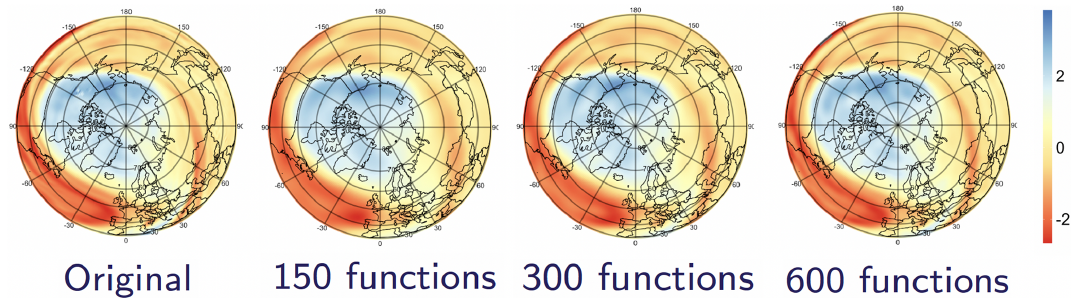
Figure 1. Original (left) and reconstructed potential vorticity field using an increasing number (150, 300, and 600) of the functional basis. The orthogonal functional basis over the spherical cap was computed using the approach in DelSole and Tippett